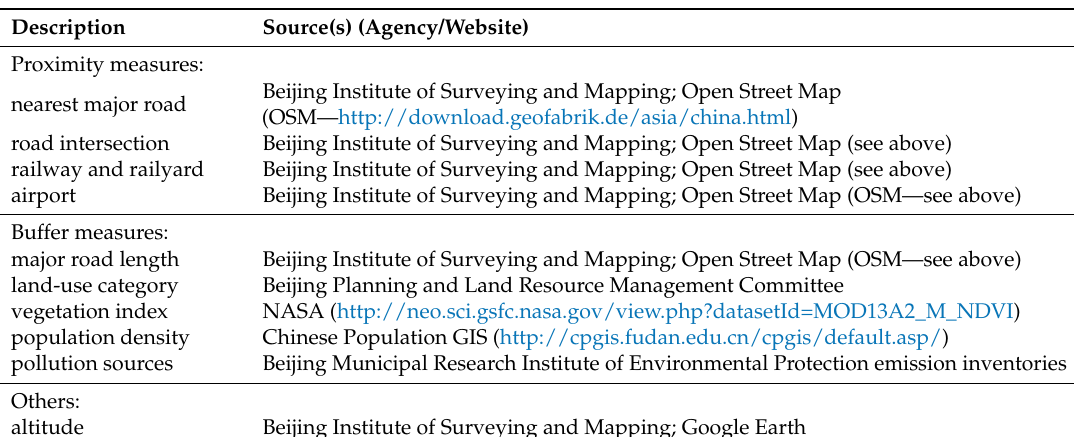
Table 2. Selected relevant geographic variables for Beijing and selected potential sources of